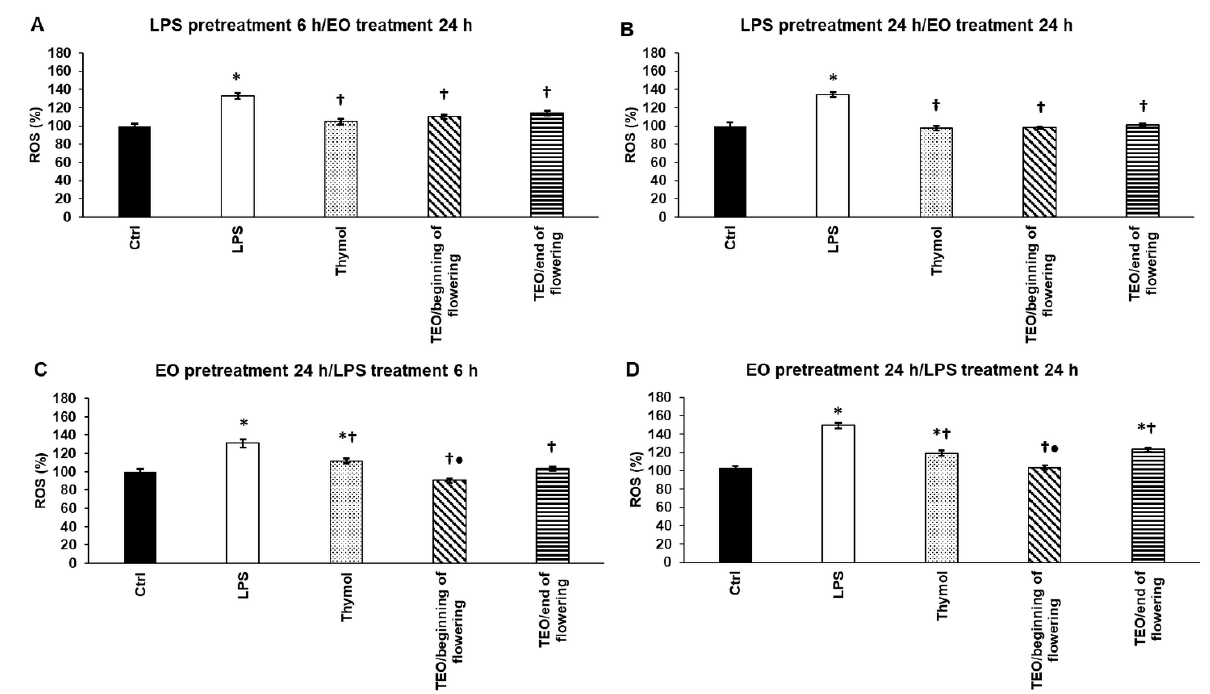
Figure 2. Determination of the effects of thymol and TEOs on reactive oxygen species (ROS) generated by LPS. As a control, the THP-1 cells were treated with DMSO, the carrier of EOs or distilled water, and the solvent of LPS in the same order and for the same time as in the case of the EO and LPS pretreatments. For LPS treatment, the cells were treated with LPS for 6 h or 24 h, and then they were treated with 500-fold diluted DMSO for 24 h or were treated with DMSO for 24 h, and then they were treated with LPS for 6 h and 24 h. For LPS pretreatment, the cells were treated with LPS for 6 h and 24 h, and then they were treated using 500-fold diluted thymol or TEOs for 24 h. For EO pretreatment, the cells were treated with 500-fold diluted thymol or TEOs for 24 h followed by LPS treatments for 6 h and 24 h. Intracellular ROS production was determined by using Fluorometric Intracellular ROS Kit and was expressed as % compared to the control. The bars represent mean values, and error bars represent standard deviation (SD) for three independent experiments (n = 3). The assays were carried out in quadruplicate in each experiment. Asterisk indicates p < 0.05 compared to the control. Cross marks p < 0.05 compared to LPS treatment. Bullet marks p < 0.05 compared to TEO/end of flowering. Statistical analysis was carried out by two-way ANOVA followed by Scheffe’s post hoc test.